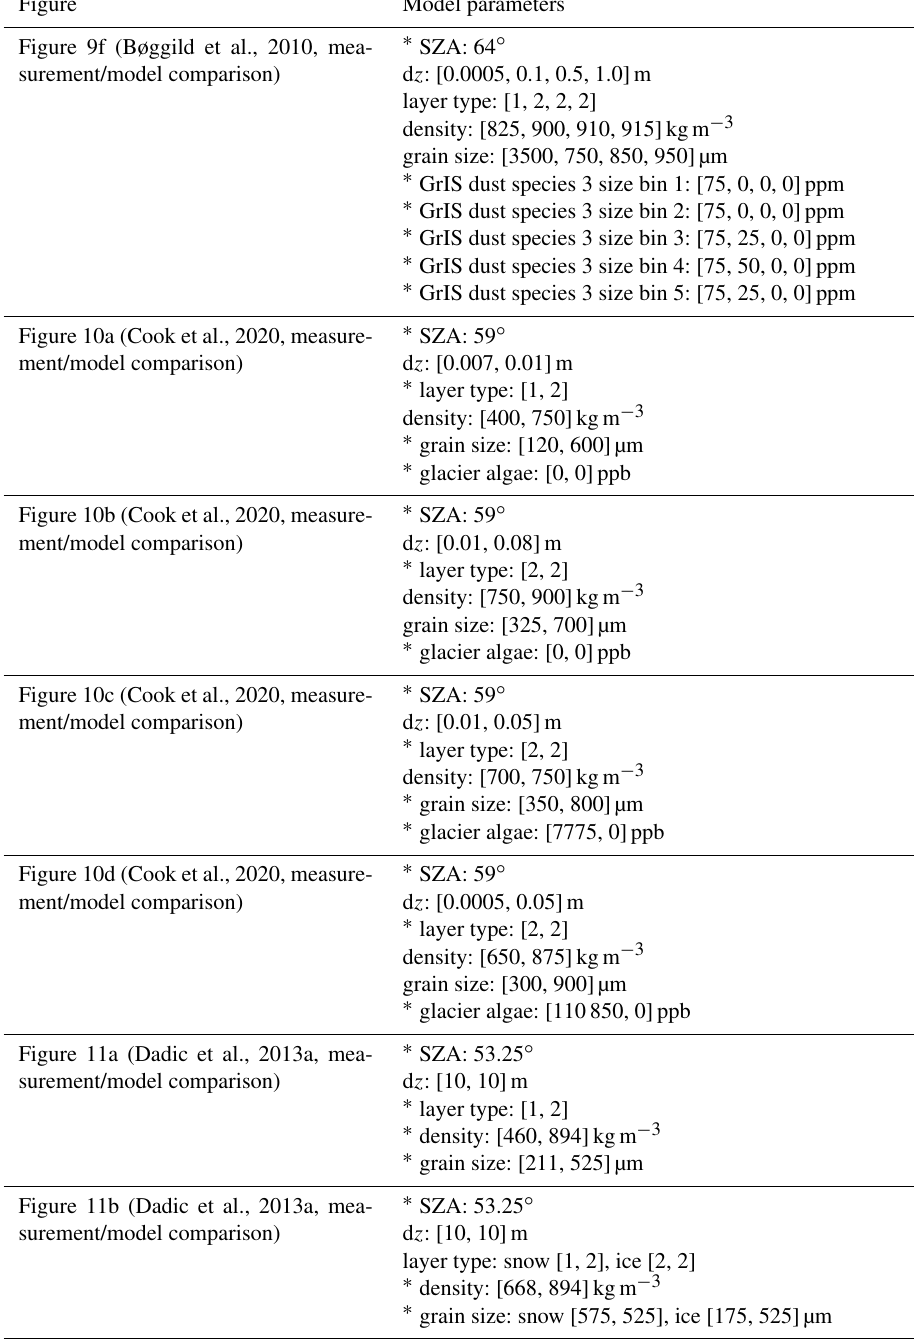
Figure Model parameters Figure 9f (Bøggild et al., 2010, mea- surement/model comparison)